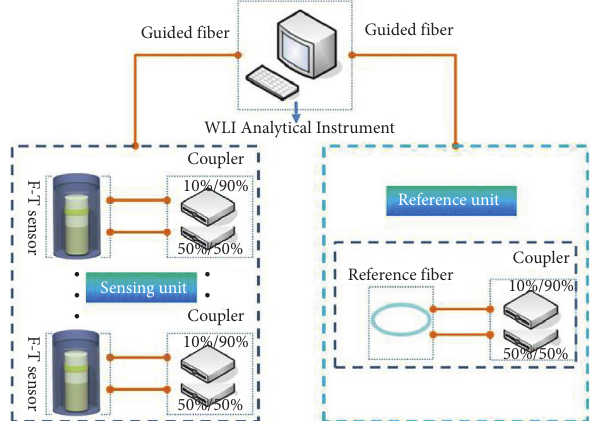
Figure 6: Accelerate F-T cycle.